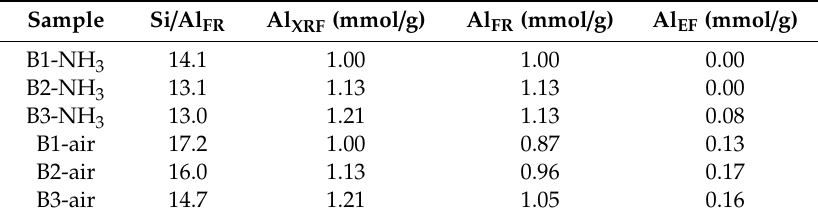
Figure 4. 29 Si MAS NMR spectra of B1-B3 samples calcined in ammonia ( a ) and in air ( b ) solid lines, together with spectra simulation dashed and gray lines. Table 1. Results of chemical analysis (XRF) and concentration of framework and extra-framework Al, Si / Al FR and Al FR estimated from 29 Si MAS NMR, Al EF estimated as a di ff erence between Al XRF and Al FR .